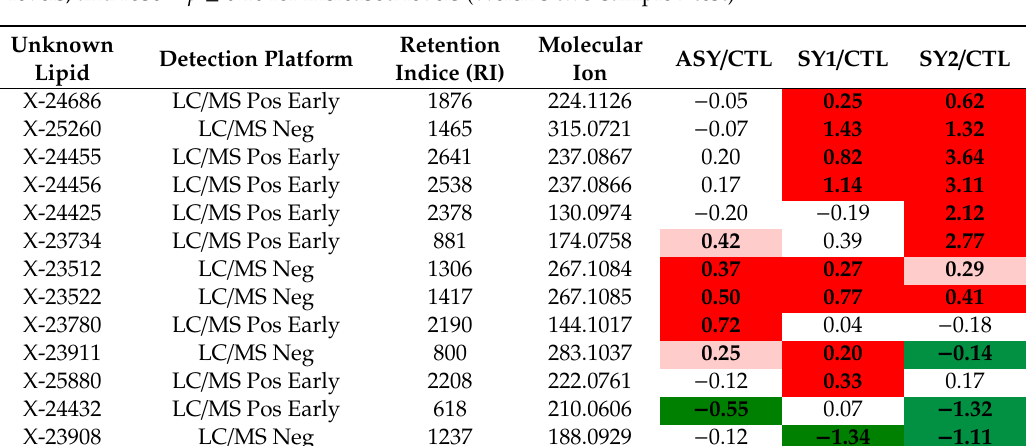
Table 2. Characteristics of 13 unidentified lipids species that strongly discriminated leaf groups of